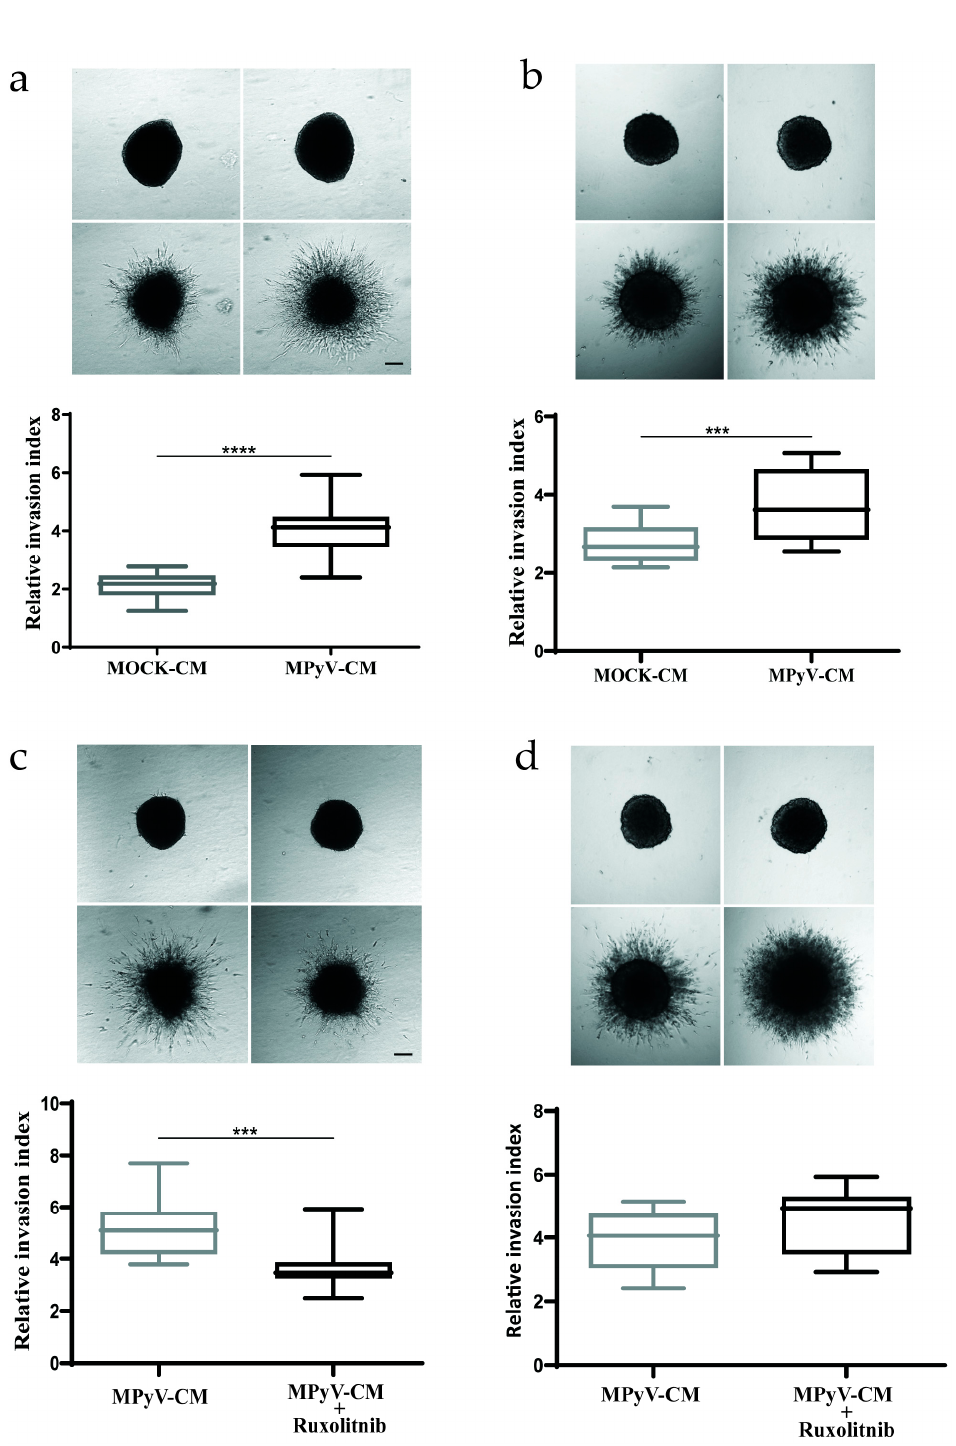
Figure 6. MPyV-induced cytokine environment promotes cell invasiveness. ( a ) Invasiveness of MEF cell-spheroid in a 3D collagen matrix in the presence of MPyV-CM or MOCK-CM. ( b ) Invasiveness of CT26 cell-spheroid in a 3D collagen matrix in the presence of MPyV-CM or MOCK-CM. ( c ) The effect of JAK1/2 inhibitor ruxolitinib on MPyV-CM-mediated MEF spheroid invasiveness a 3D collagen matrix. ( d ) The effect of JAK1/2 inhibitor ruxolitinib on MPyV-CM-mediated CT26 spheroid invasiveness in a 3D collagen matrix. The data are the mean ± SEM of three independent experiments with a minimum of five spheroids per condition. The spheroid invasiveness was analyzed 48 h post-treatment. *** p < 0.001; **** p < 0.0001; one-way ANOVA